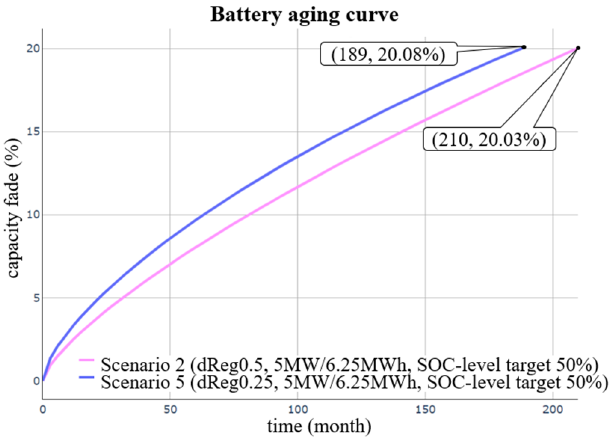
Figure 17. The result under dReg0.5 and dReg0.25.